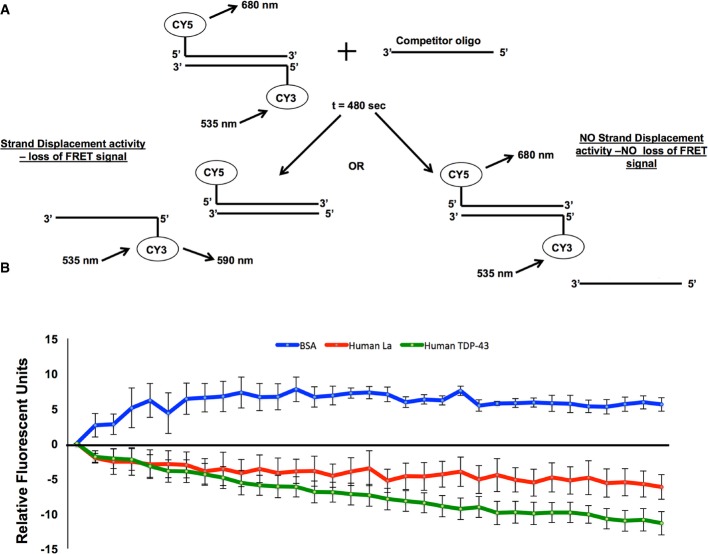
Human TDP-43 displays strand dissociation activity in vitroAssay for strand displacement activity (adapted from Naeeni et al, 2012).RNA strand dissociation activity was measured as a change in relative FRET signal (y-axis) over time (x-axis) of two complementary, fluorescently labeled (Cy5 and Cy3, respectively) RNA oligos (annealed for 480 s at 37°C) following the addition of tenfold molar excess of a competitor oligo complementary to the Cy5-labeled RNA molecule. RNA molecules were excited at 535 nm, and FRET signal was recorded at 680 nm. Initial FRET fluorescence was set to zero and then measured every 15 s for 480 s. Data represent results from six to seven independent assays. Error bars, SEM calculated between replicates at each 15 s time point. The assay was done in the presence of Bovine Serum Albumin (BSA) protein (blue line); recombinant human Lupus Antigen (Human La) (red line), and recombinant human Tar-DNA Binding protein 43 (TDP-43) (green line).